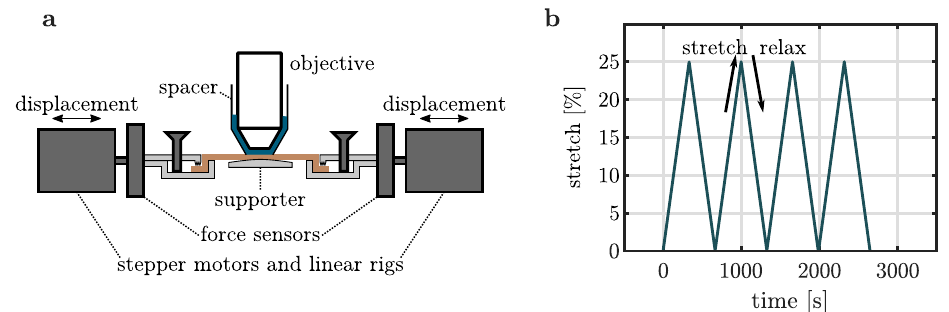
Figure 1. Experimental set-up and deformation protocol. ( a ) Schematic illustration of the multiphoton microscope stretching device. ( b ) Deformation protocol consisting of four repeated cycles with successive stretching and